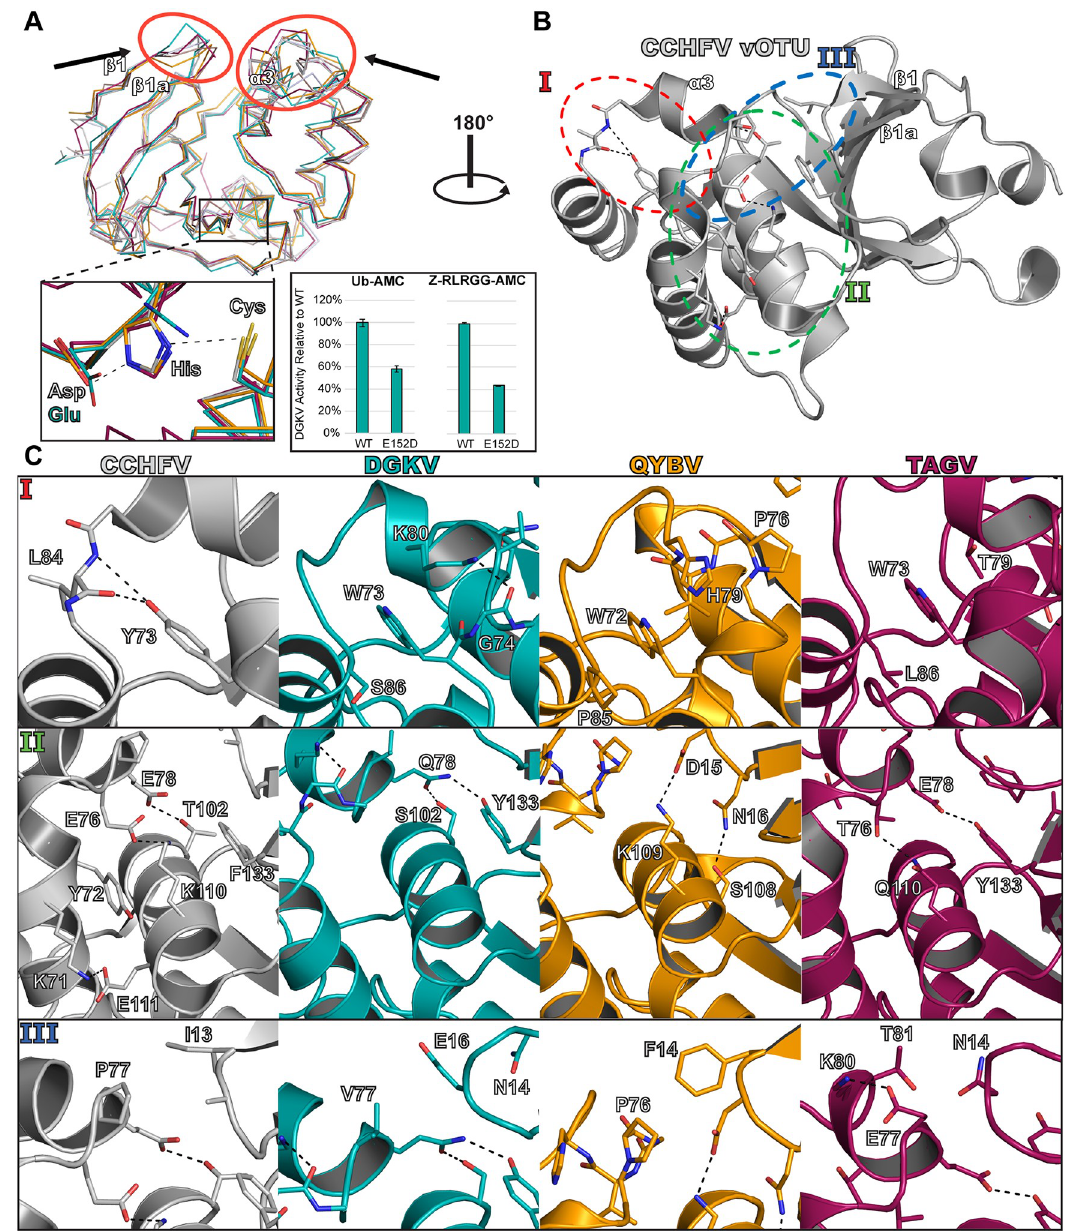
Fig 4. Structural comparison of new vOTU structures. (A) Secondary structure overlay of the vOTUs from CCHFV, DGKV, QYBV, and TAGV. The red circles highlight areas of the binding interface that show large structural divergence. The region of the active site is denoted by a black box, with a closeup shown. The relative activities of the DGKV vOTU WT and E152D mutant for Ub-AMC and the peptide Z-RLRGG-AMC are shown, with error bars representing the standard deviation of two independent experiments. (B-C) Specific molecular interactions accounting for structural differences can be identified in distinct regions of the vOTUs. CCHFV vOTU is colored gray, DGKV vOTU in teal, QYBV vOTU in orange, and TAGV vOTU in magenta. Black dashed lines denote atom pairs that are within hydrogen bonding